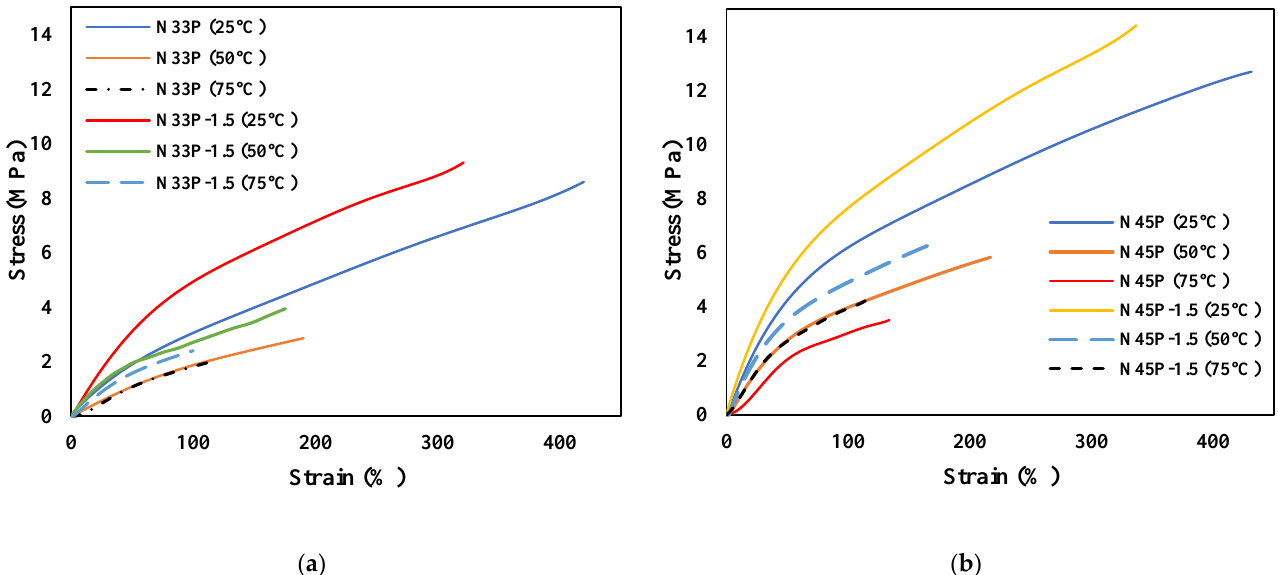
Figure 6. Stress – strain curves at 25, 50, and 75 °C for ( a ) N33P and N33P-1.5; ( b ) N45P and N45P- Figure 6. Stress–strain curves at 25, 50, and 75 ◦ C for ( a ) N33P and N33P-1.5; ( b ) N45P and 1.5 .